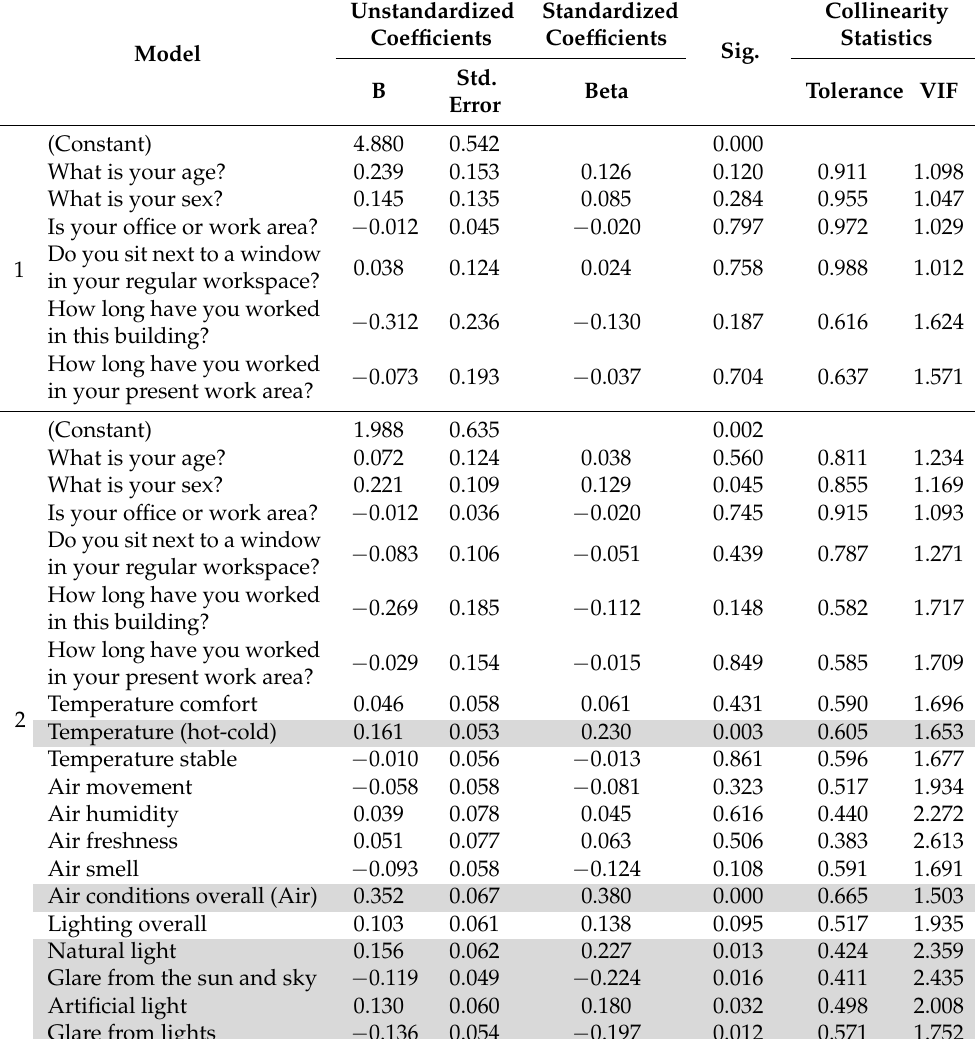
Table 5. Coefficient results of the influence of building conditions on comfort.